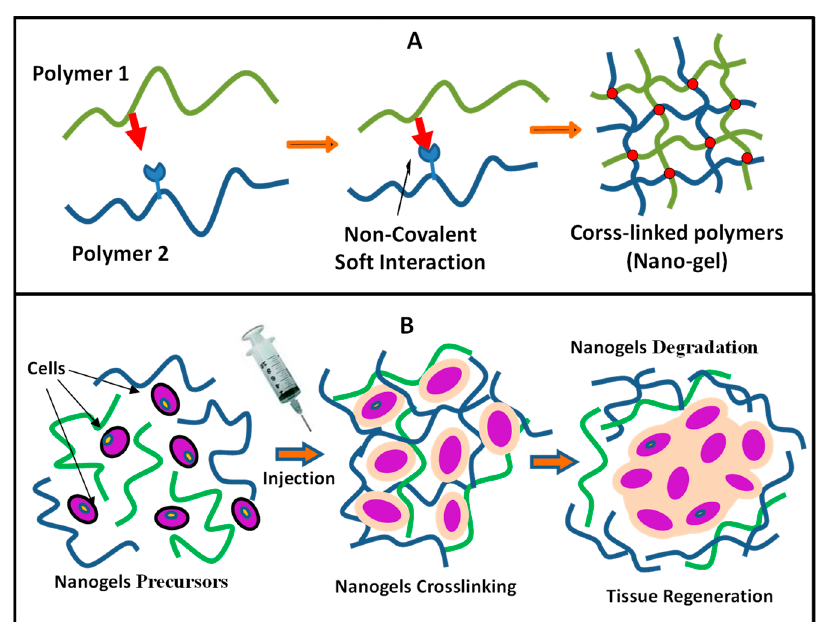
Figure 11. Schematic representation of the non-covalent forces acting on a cross-linked polymer (nano-gel) ( A ). In situ formation of a scaffold in tissue engineering application by injection into the wound of a polymer/cell solution and formation of a cross-linked polymer network ( B ).